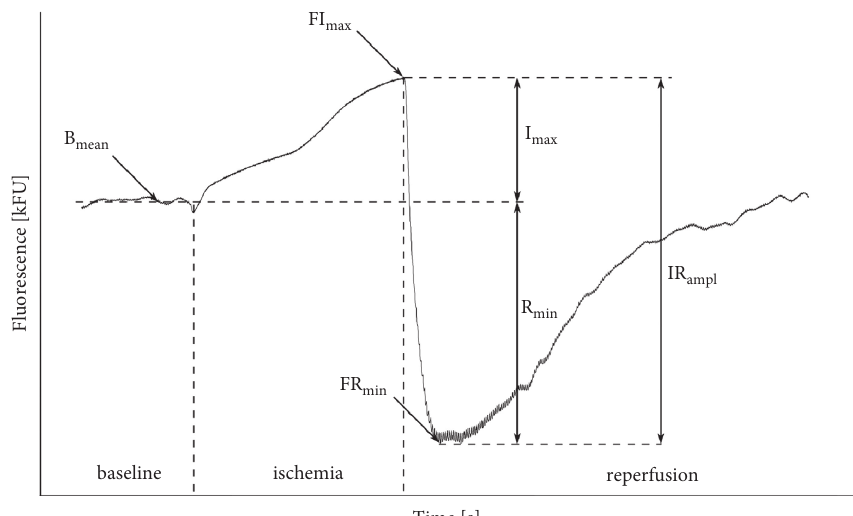
Figure 2: This is an example of the 460nm skin fluorescence recorded at rest, during 100-second transient ischemia and the following reperfusion. For details on measured parameters, refer to the main text in the methodology